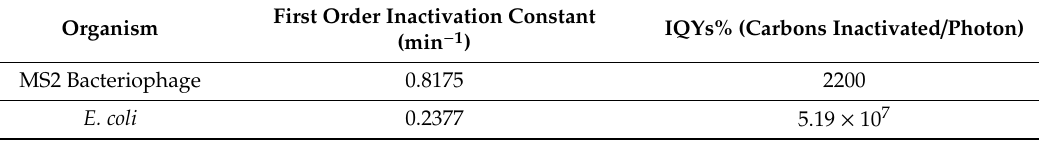
Table 6. IQYs% for E. coli and MS2 bacteriophage using TiO 2 -near UV-mediated inactivation [10,157]. First Order Inactivation Organism